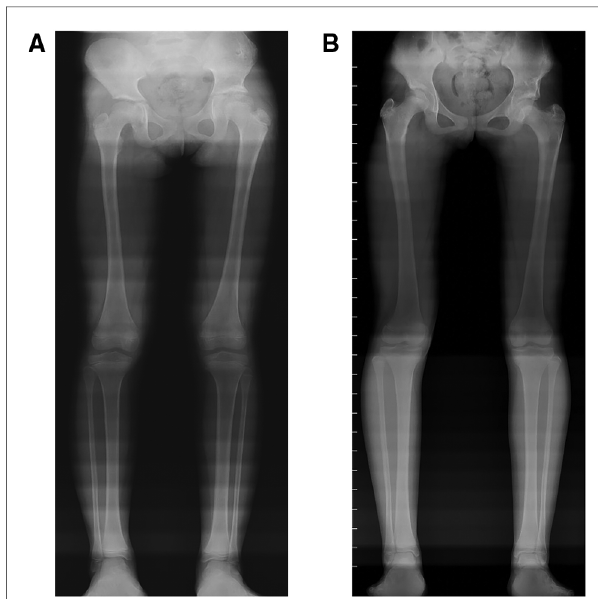
FIGURE 6 Two cases of LLD after pelvic osteotomy combined with femoral shortening osteotomy ( A ) full-length lower extremity weight-bearing radiographs obtained 50 months after the Salter pelvic osteotomy combined with femoral shortening osteotomy. The length of left and right femur was 350 mm and 343 mm respectively. The whole length of the left and right lower limb was 647 mm and 638 mm respectively. ( B ) Full-length lower extremity weight-bearing radiographs obtained 47 months after the Pemberton osteotomy combined with femoral shortening osteotomy. The length of left and right femur was 378 mm and 391 mm respectively. The whole length of the left and right lower limb was 706 mm and 721 mm respectively.